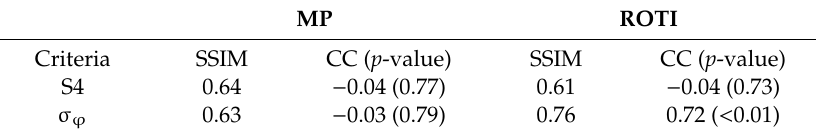
Table 6. SSIM and CC between the maps shown in Figure 7c.